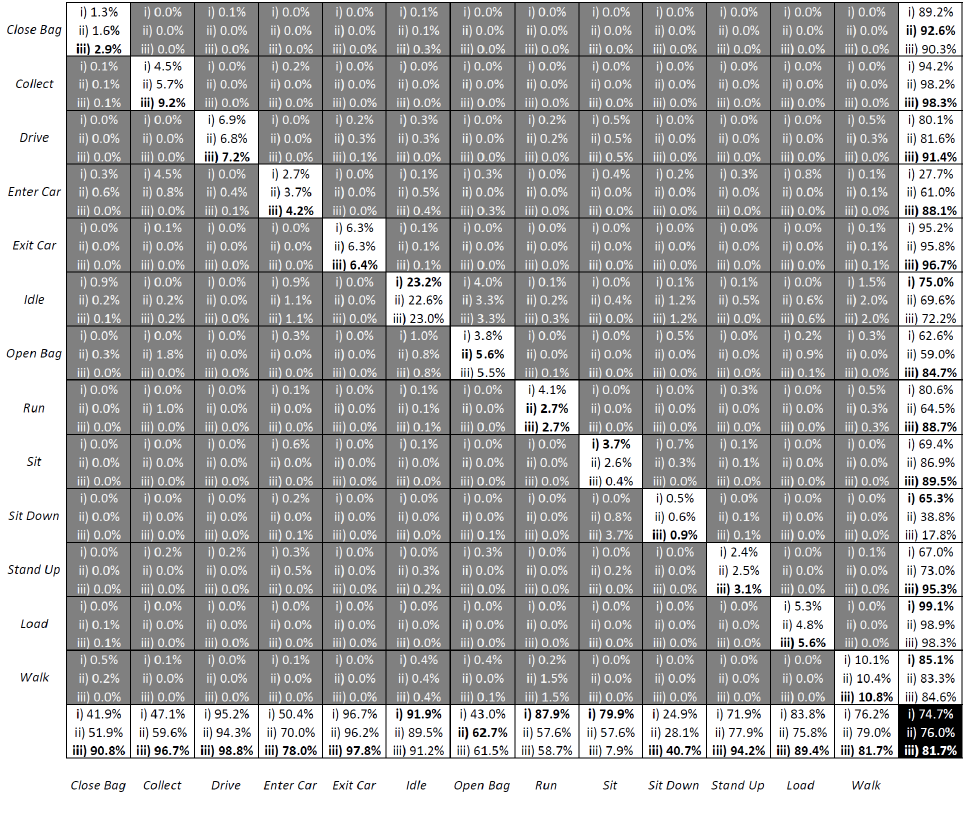
Figure 14. The confusion matrix of Fuzzy-LSTM* (i), FS-LSTM* (ii) and FS-LSTM** (iii). Superior classification accuracy results are identified in bold.